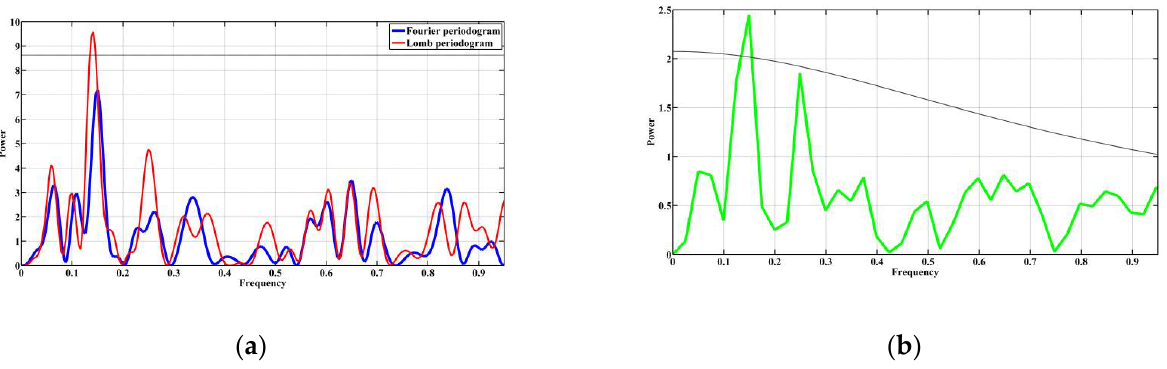
Figure 6. The results of applying spectral methods to the magnetic susceptibility data of the Lower Maeotian deposits of the Zhelezny Rog Cape section (Figure 2b): ( a ) Fourier and Lomb periodograms (the black bold solid line indicates the 95% confidence interval for the Lomb periodogram); ( b ) the spectrum constructed by the REDFIT algorithm (the black bold dotted line indicates the 95% confidence interval).